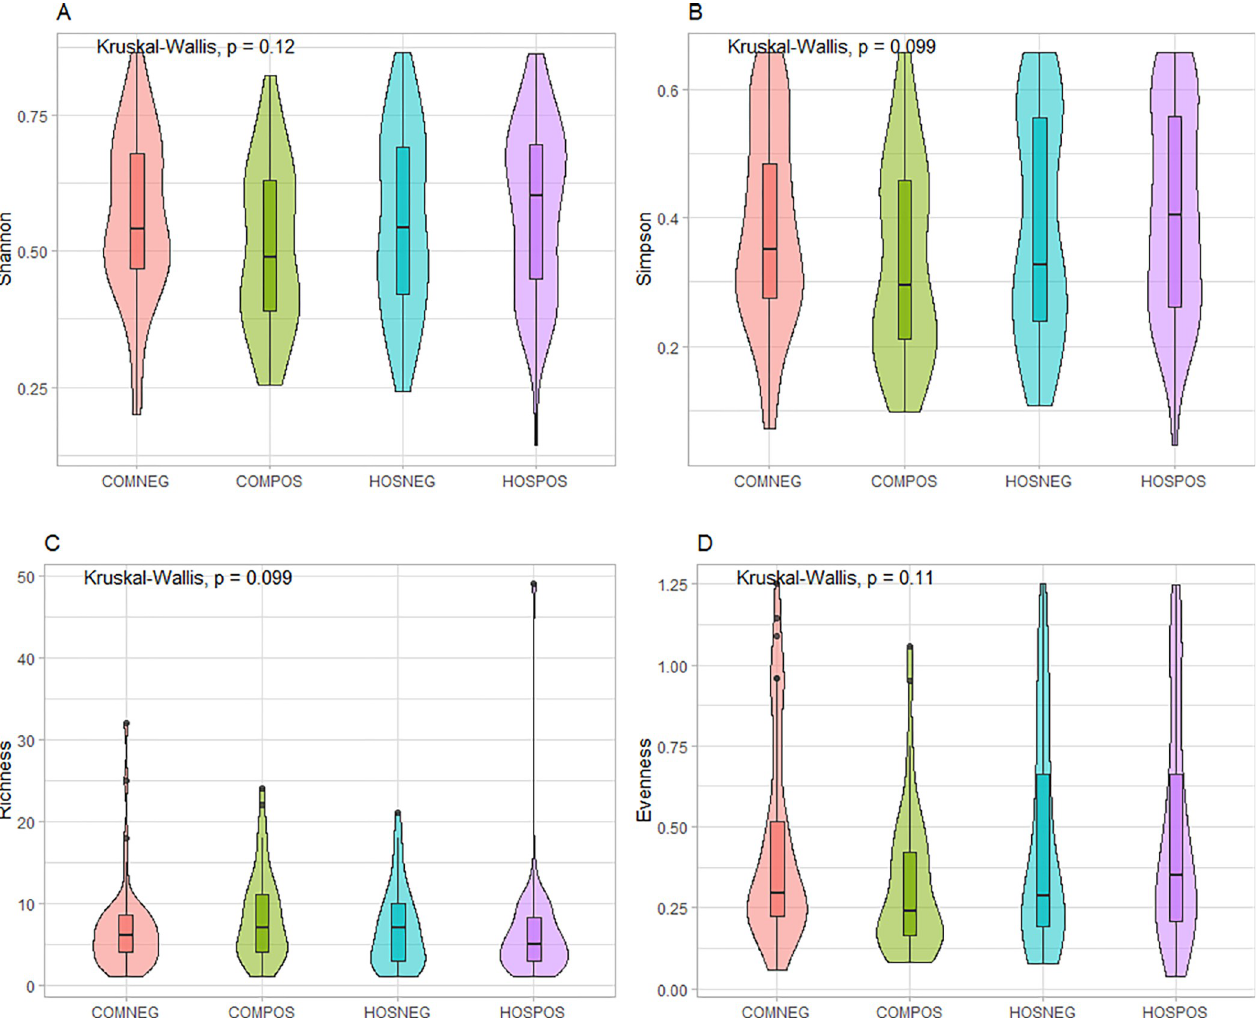
Fig 1. Alpha diversity differences. Genus-level differences in alpha diversity among our study groups summarized through A. Shannon diversity index, B. Simpson diversity index, C. Taxa richness, D. Evenness.